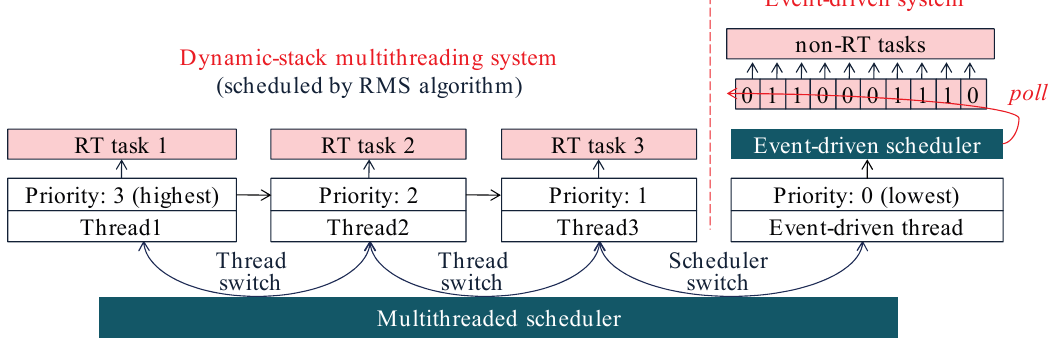
Figure 11. An event-driven scheduling system in LiveOS is also implemented as a